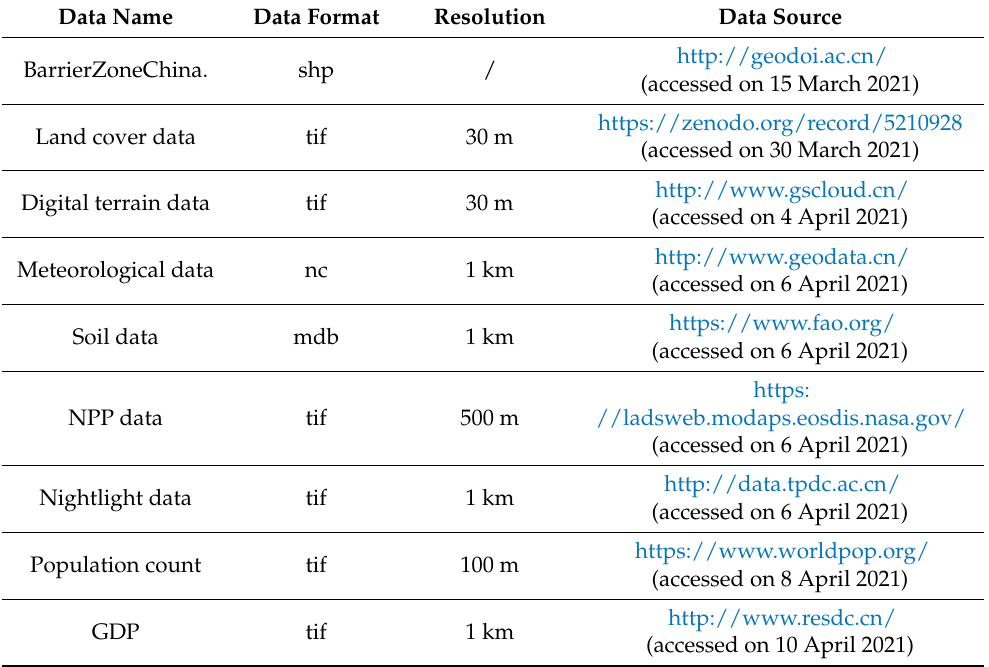
Table 1. Data name, format, and